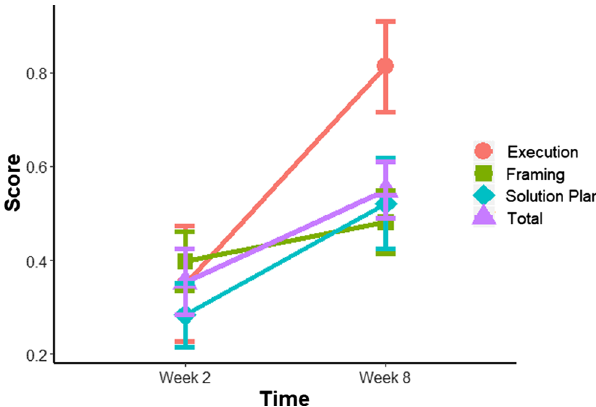
FIG. 6. Scores on execution (circle), framing (square), planning (diamond), and total (triangle) scores on homework problems from week 2 and week 8 for 8 students in Physics 41. Error bars represent standard errors.